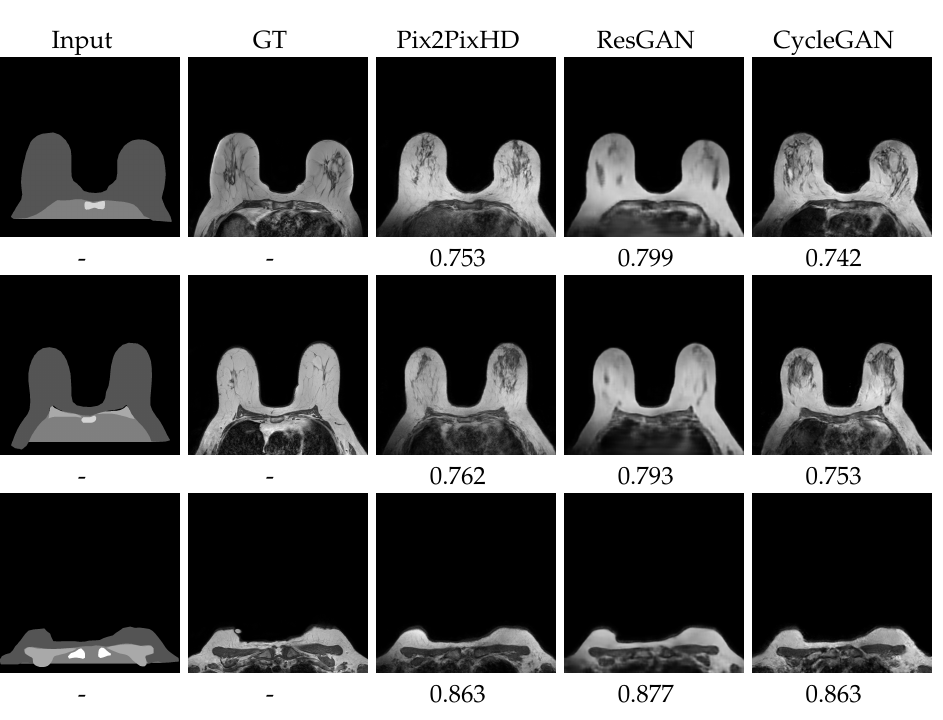
), mean ( µ ), standard ⊥